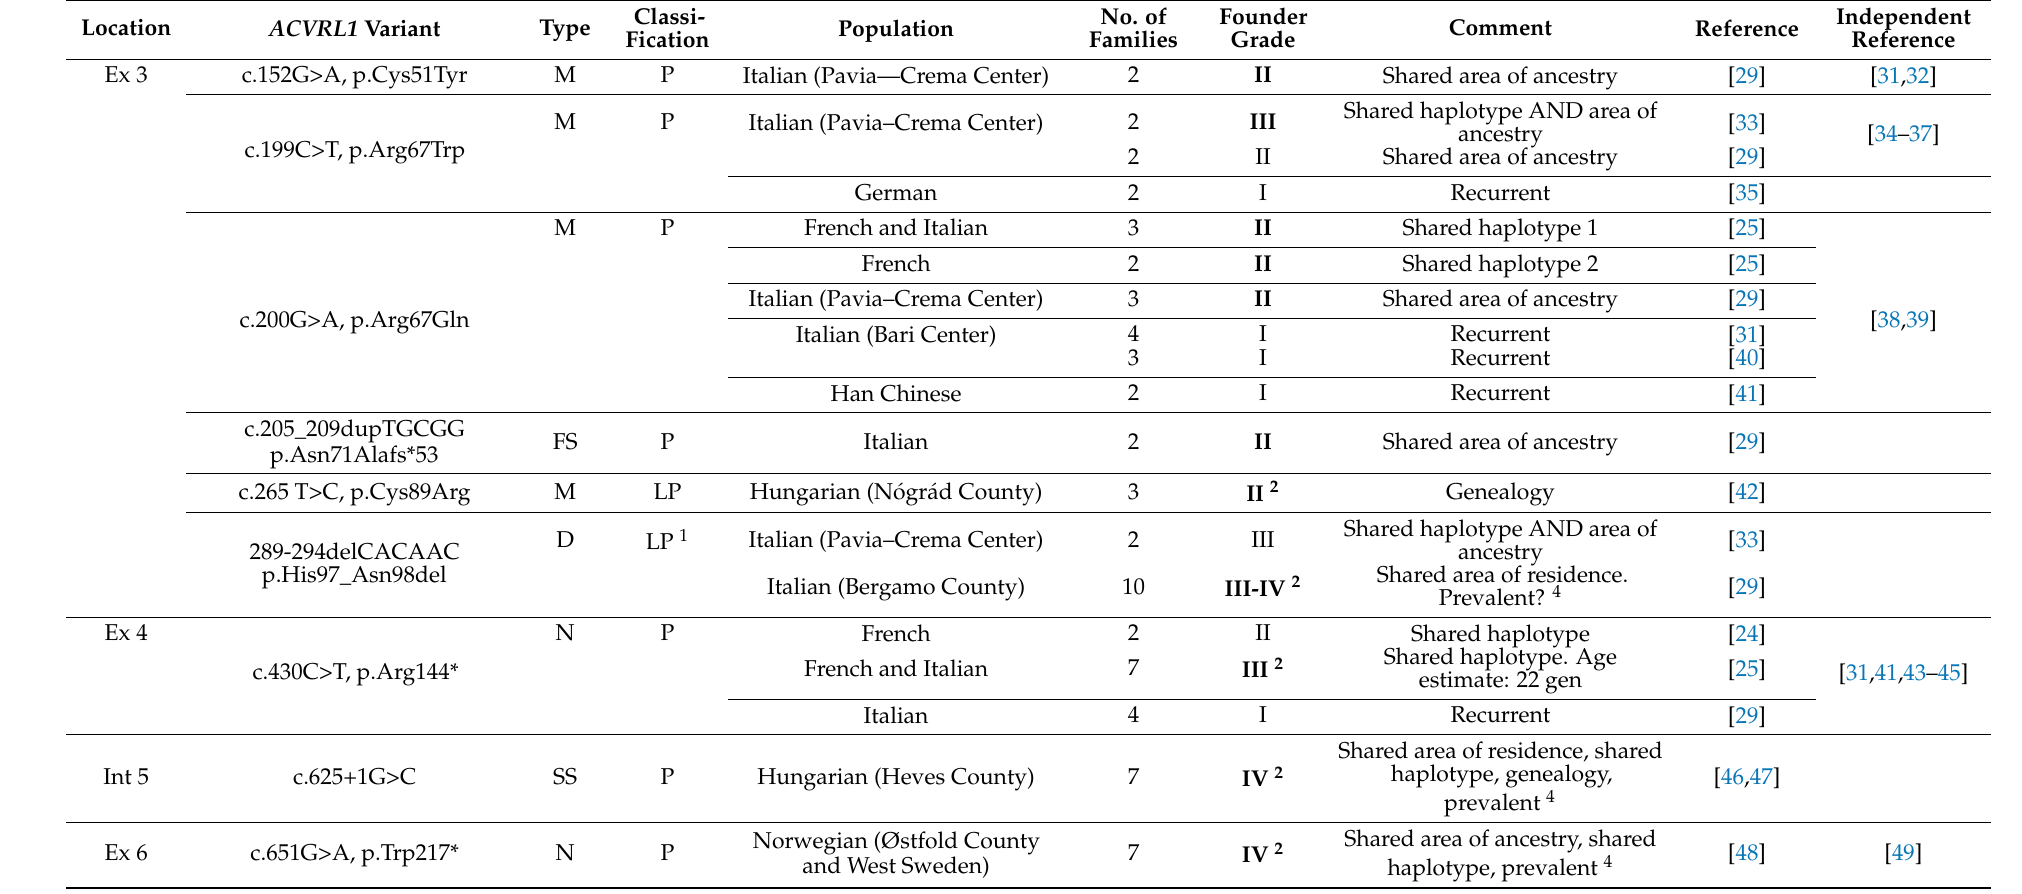
Table 2. Grade I to IV founder variants in the ACVRL1 and ENG